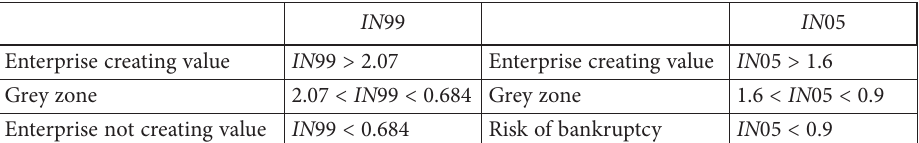
Table 3. Indices IN evaluation table (source: authors based on Neumaierová & Neumaier, 2002 and Neumaierová & Neumaier, 2005) IN 99